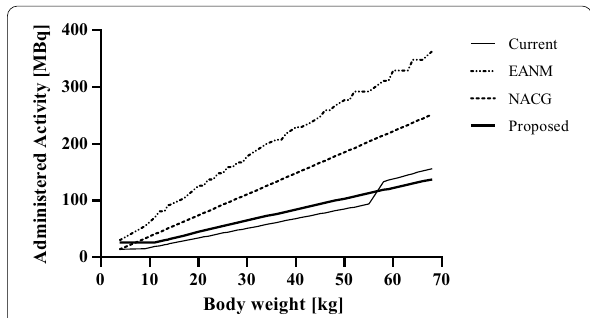
Fig. 4 Comparison of [ 18 F]FDG dosage regimens. Current study, EANM, NACG and the proposed dose